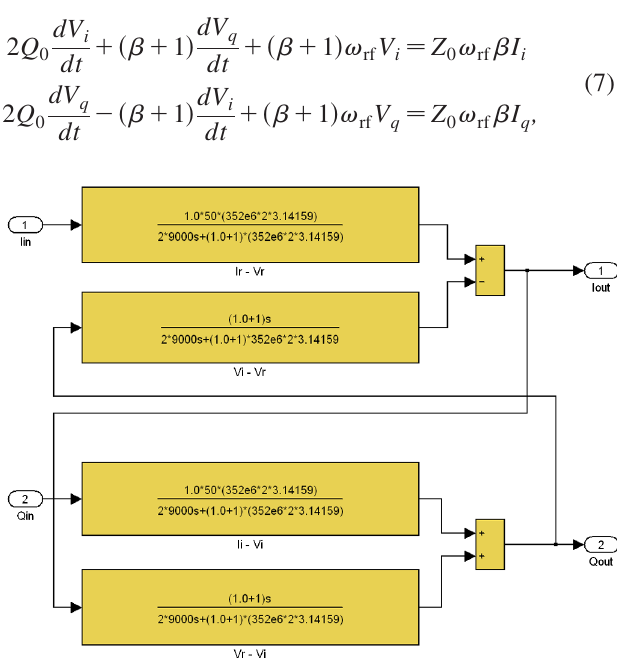
FIG. 10. Baseband-equivalent model of the RFQ represented as a MIMO system in MATLAB-SIMULINK .